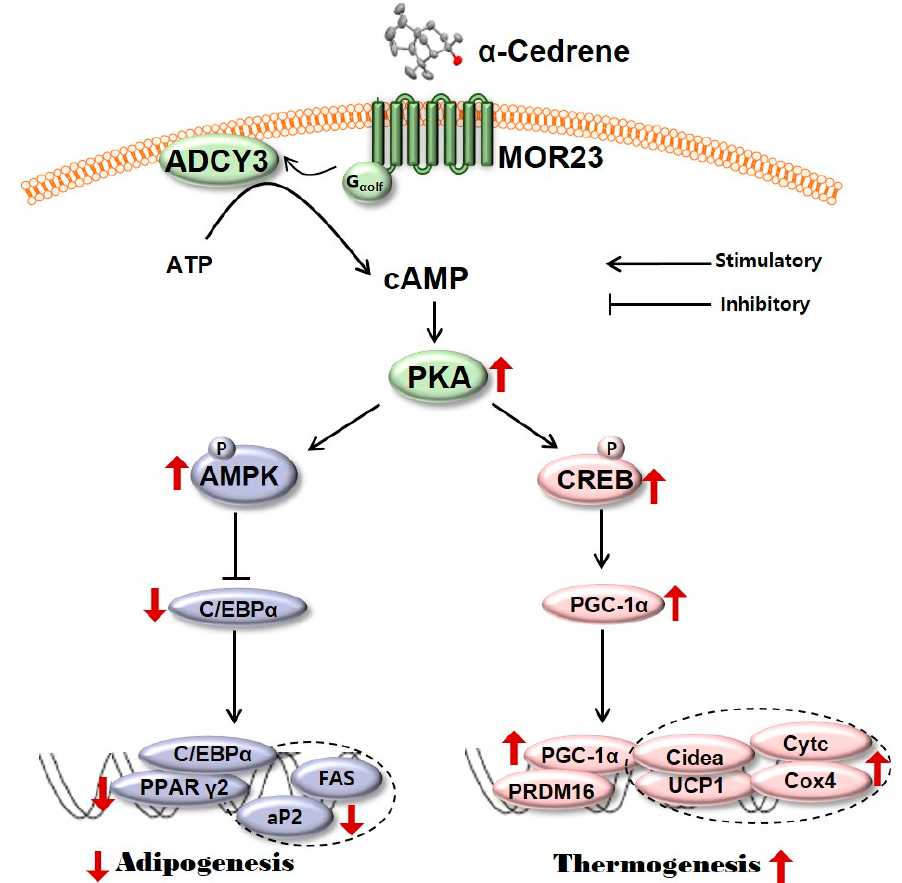
Figure 5. A schematic diagram illustrating the proposed mechanism by which MOR23 responding to α -cedrene regulates adipogenesis and thermogenesis. MOR23, mouse olfactory receptor 23; ADCY3, adenylyl cyclase 3; cAMP, cyclic adenosine monophosphate; PKA, protein kinase A; AMPK, 5'-adenosine monophosphate (AMP)-activated protein kinase; CREB, cAMP-responsive element-binding protein; C/EBP α , CCAAT/enhancer binding-protein α ; PGC-1 α , peroxisome proliferator-activated receptor gamma coactivator 1-alpha; PPAR γ 2, peroxisome proliferator-activated receptor γ 2; aP2, adipocyte fatty acid binding protein; FAS, fatty acid synthase; PRDM16, PR domain containing 16; Cidea, cell death activator CIDE-A; UCP1, uncoupling protein 1; Cytc, cytochrome c; Cox4, cytochrome c oxidase subunit 4.